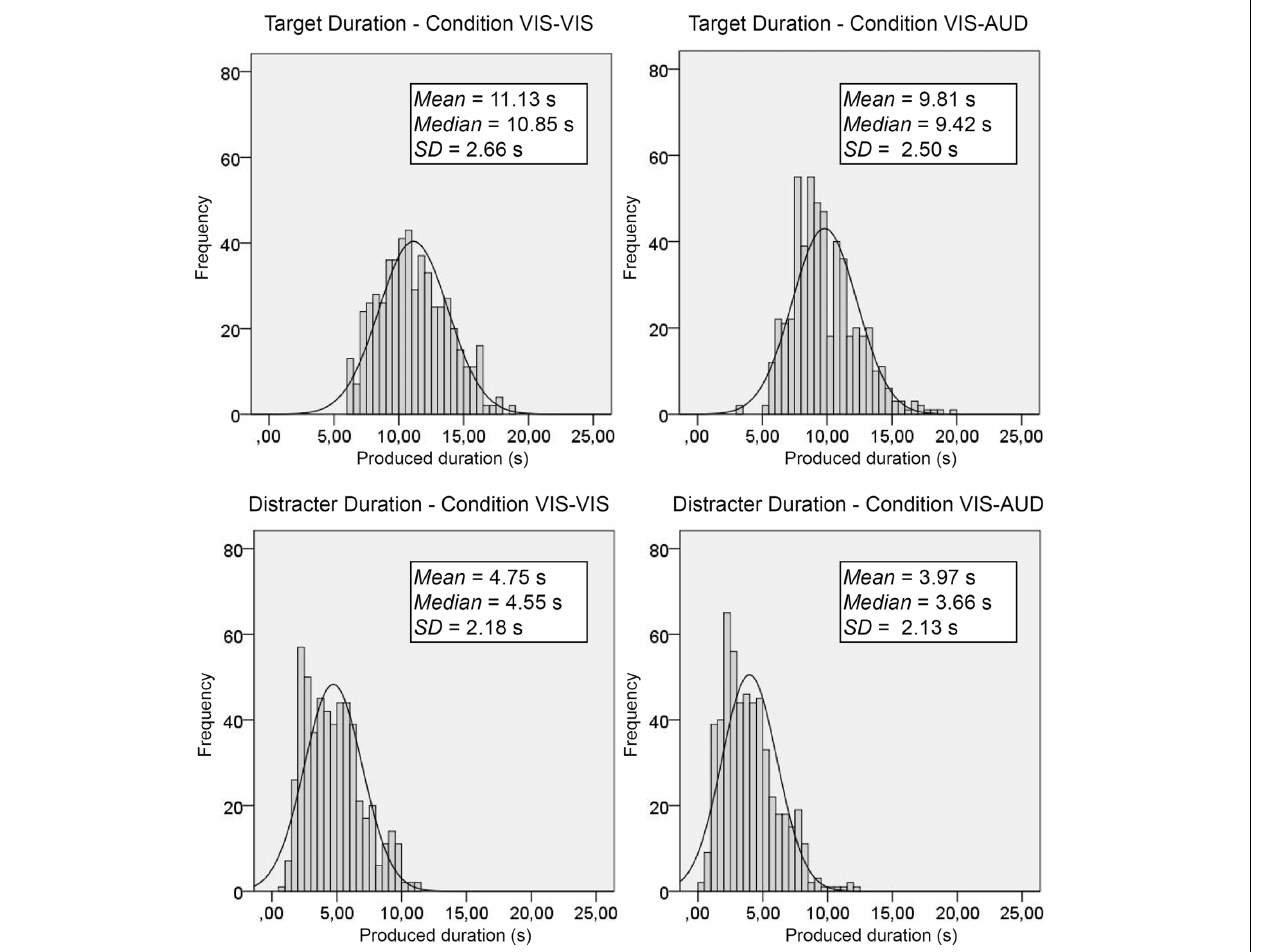
with a Gaussian curve with the same mean and the same SD as the frequency distribution. Additionally, the means, the medians, and the SDs of the frequency distributions are depicted in the figure.